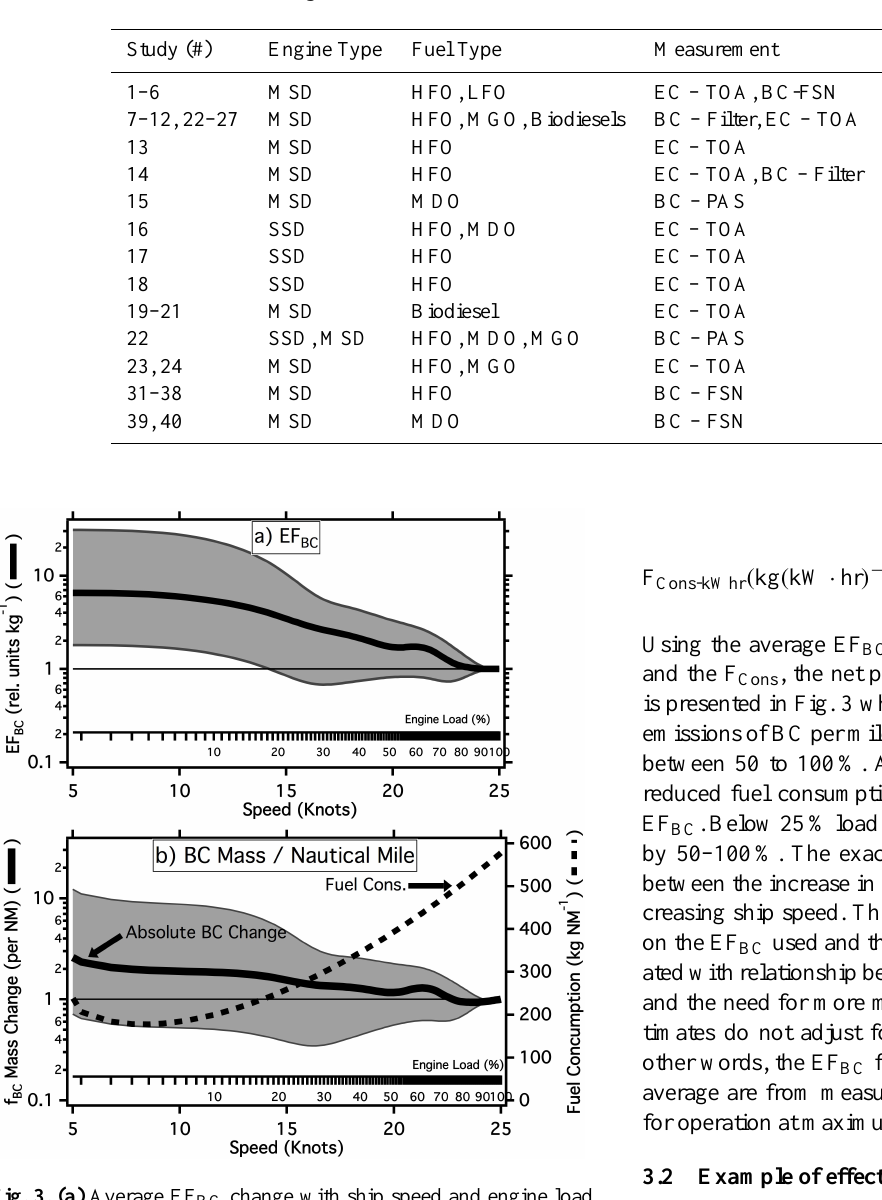
(example taken from Lack et al., 2011). F Cons is shown as the black dashed line in Fig.